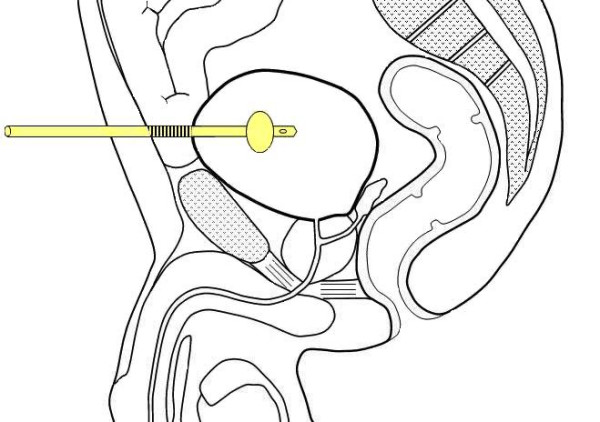
Suprapubic catheter traverse through a small bowel loop between the bladder and the abdominal wall.